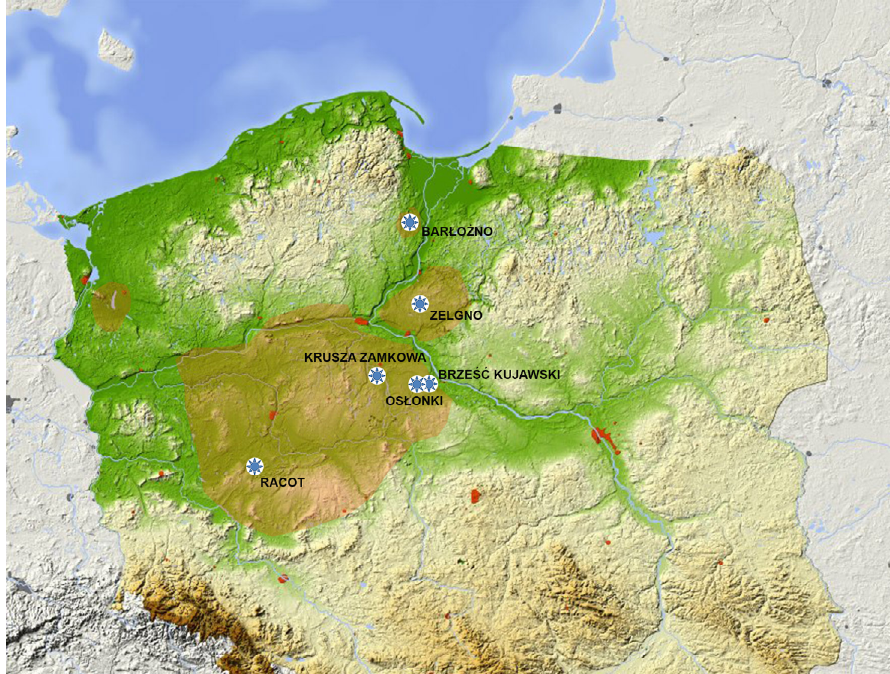
Fig. 1. Map of the BKK. Marked are the most important Brześć Kujawski type sites.